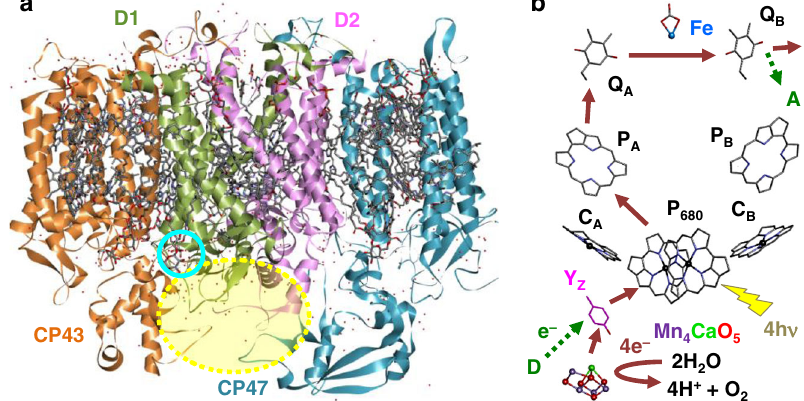
Fig. 1 Structure and function of photosystem II. a Cryo-electron microscopy structure of native plant PSII (PDB entry 5XNL). The central membrane- integral subunits with cofactors of a PSII monomer are shown (cyan circle = Mn 4 CaO 5 position). Omitting the extrinsic subunits (PsbQ, PsbP, and PsbO with approximate molecular weights of 18, 24, and 33 kDa) exposes a cavity (yellow shading, the subunits are absent in our Mn-depleted PSII). b Cofactors (truncated structures) for light-driven electron transfer in D1/D2 (Y Z , tyrosine electron acceptor from Mn 4 CaO 5 ; P 680 , primary donor chlorophyll (chl) dimer; C A,B , accessory chl; P A.B , pheophytins; Q A,B , acceptor quinones; Fe, non-heme iron with bicarbonate ligand). Green/dark-red arrows: electron transfer paths upon photo-excitation ( h ν ) of O 2 -evolving or Mn-depleted PSII (D/A, external electron